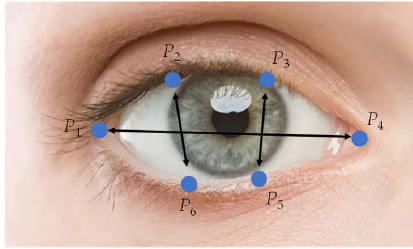
Figure 1. Key points selected around the eye for calculating EAR.